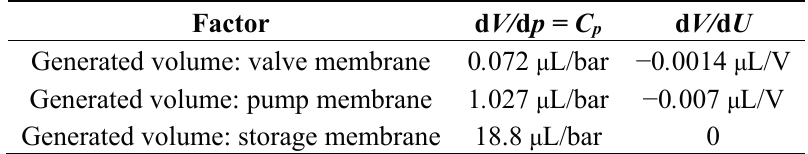
Figure 7. Assembly of the piezoelectrically driven valve- and pump-membrane. Table 2. Factors of the parametric fit function of the simulation results for the generated volume under a membrane.